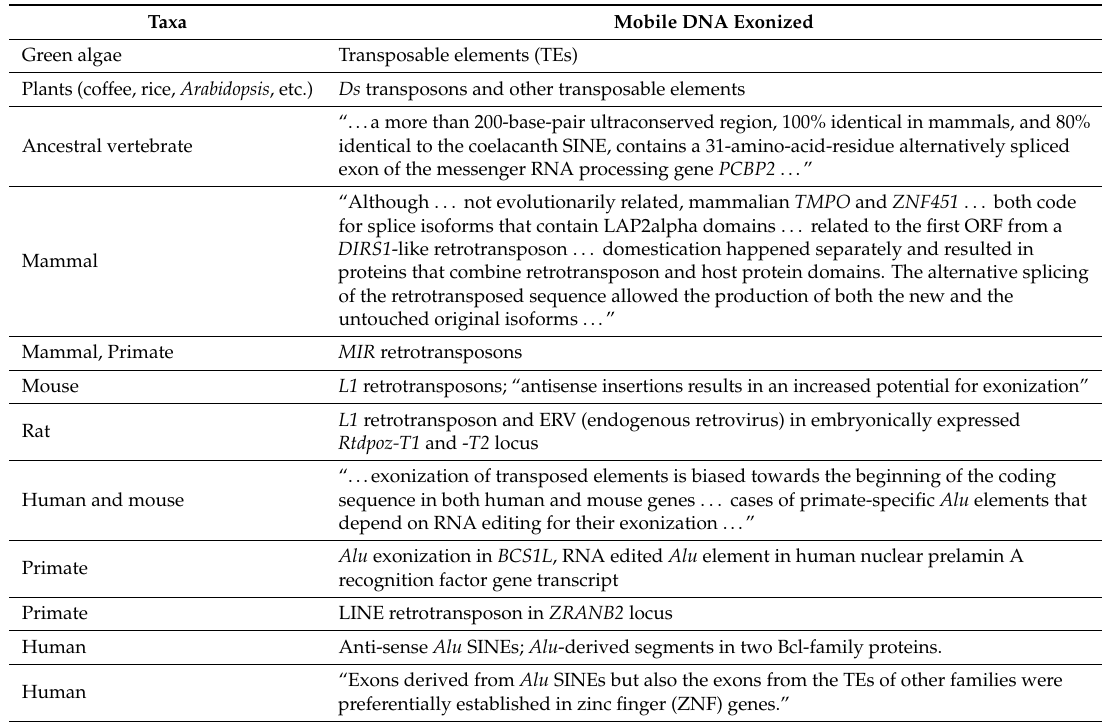
Table 11. Origination of Novel Exons (“Exonization”) from Mobile DNA